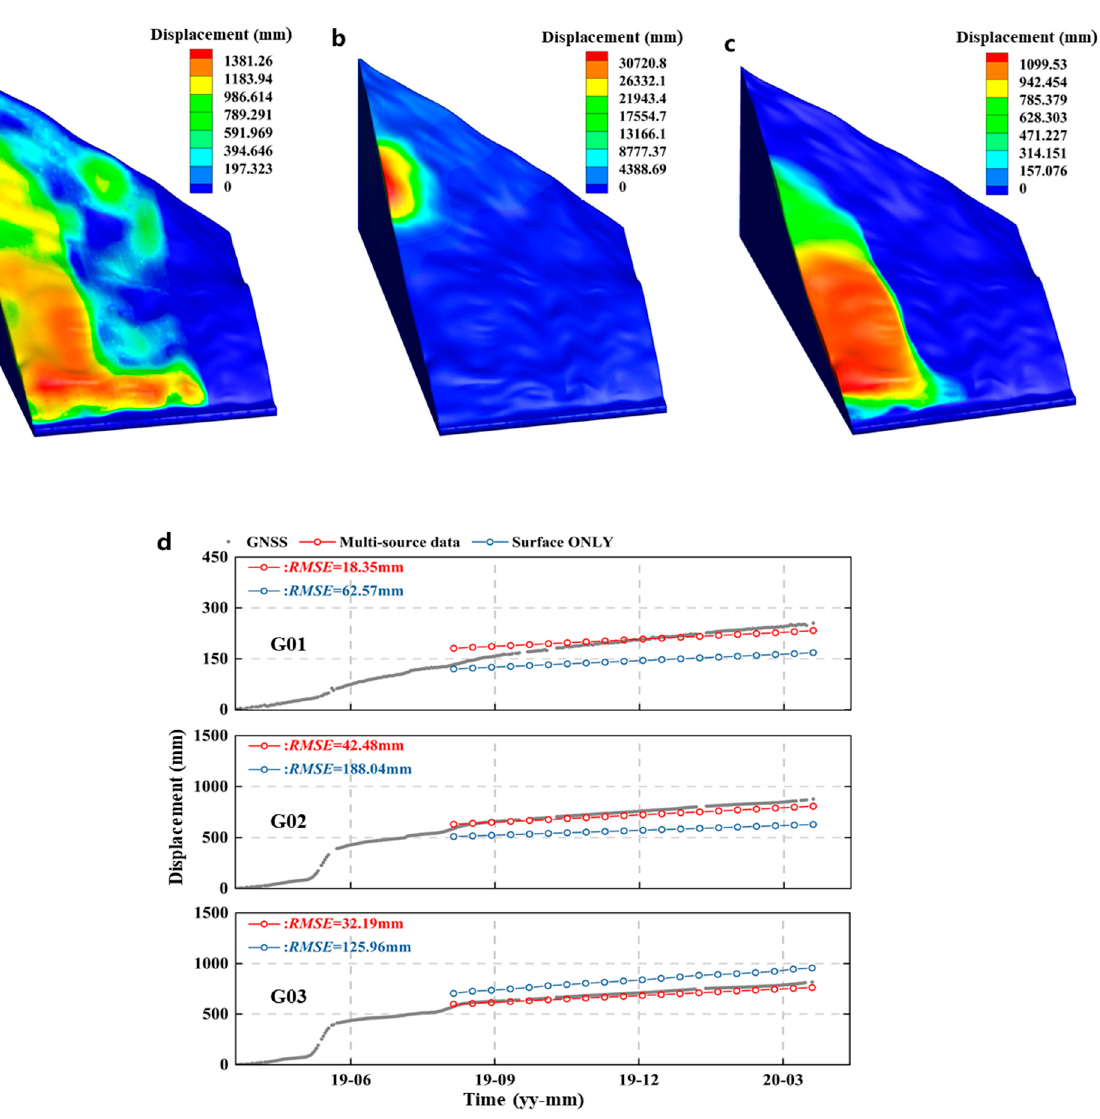
Figure 9. Comparison of the simulation results: ( a – c ) Contours of the simulated landslide displace- ment based on back analysis using “Surface ONLY”, “Internal ONLY”, and multi-source monitoring data, respectively. ( d ) Comparison of the simulation results at GNSS stations G01, G02, G03 with corresponding GNSS displacement monitoring